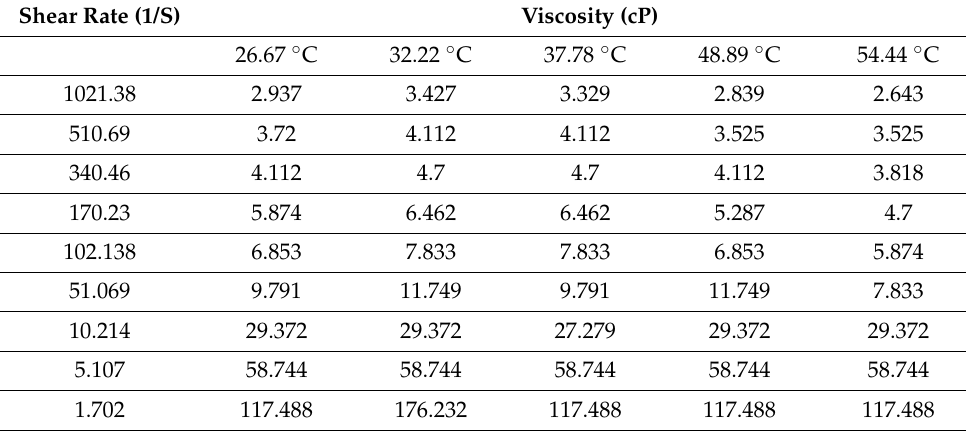
Table 3. Observed and Measured Data for Butanone (0.6%), APG (0.5%), and Xanthan Gum at Various